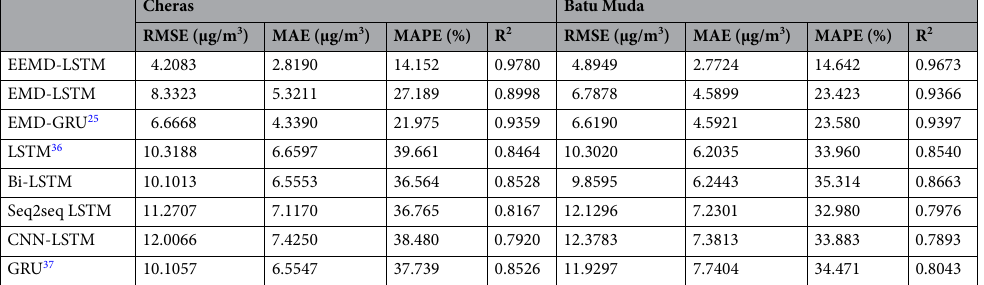
Table 5. Forecasting evaluation of deep learning